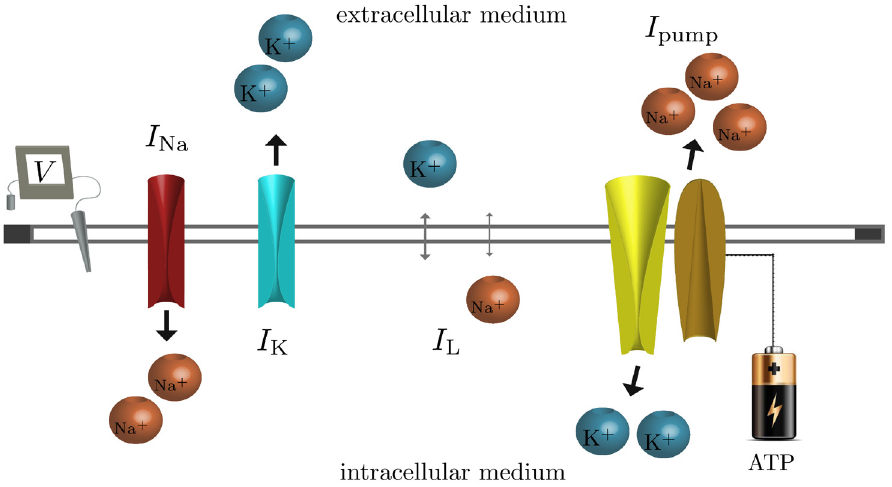
Fig 8. Summary of the dynamics represented in the model. The figure illustrates the flux of ions through the fast ), the delayed rectifier I spike generating currents, the Na-K-ATPase pump, and through the neuronal sodium ( I Na K membrane ( I L ). The mathematical representation of the currents flowing through proteins can be found in Eqs (2), (3), (8) and (4). The change of the membrane potential due to those currents is represented by Eq (1).